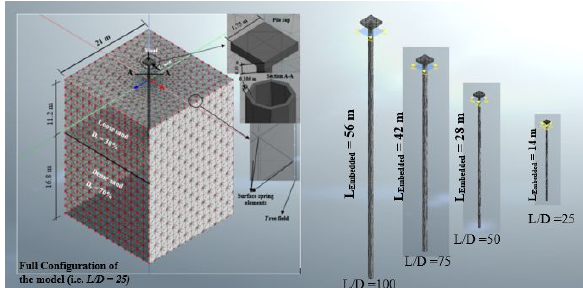
Figure 2: Configuration of soil-pile system with different pile slen- derness